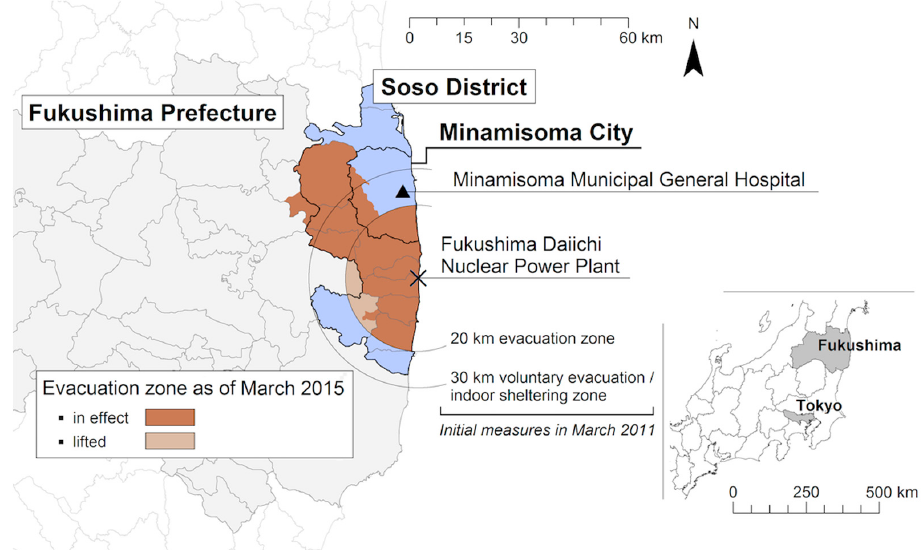
Figure 1 . Map of Minamisoma Municipal General Hospital (MMGH) in relation to Fukushima Figure 1. Map of Minamisoma Municipal General Hospital (MMGH) in relation to Fukushima Daiichi Daiichi Nuclear Power Plant and evacuation zones . Nuclear Power Plant and evacuation